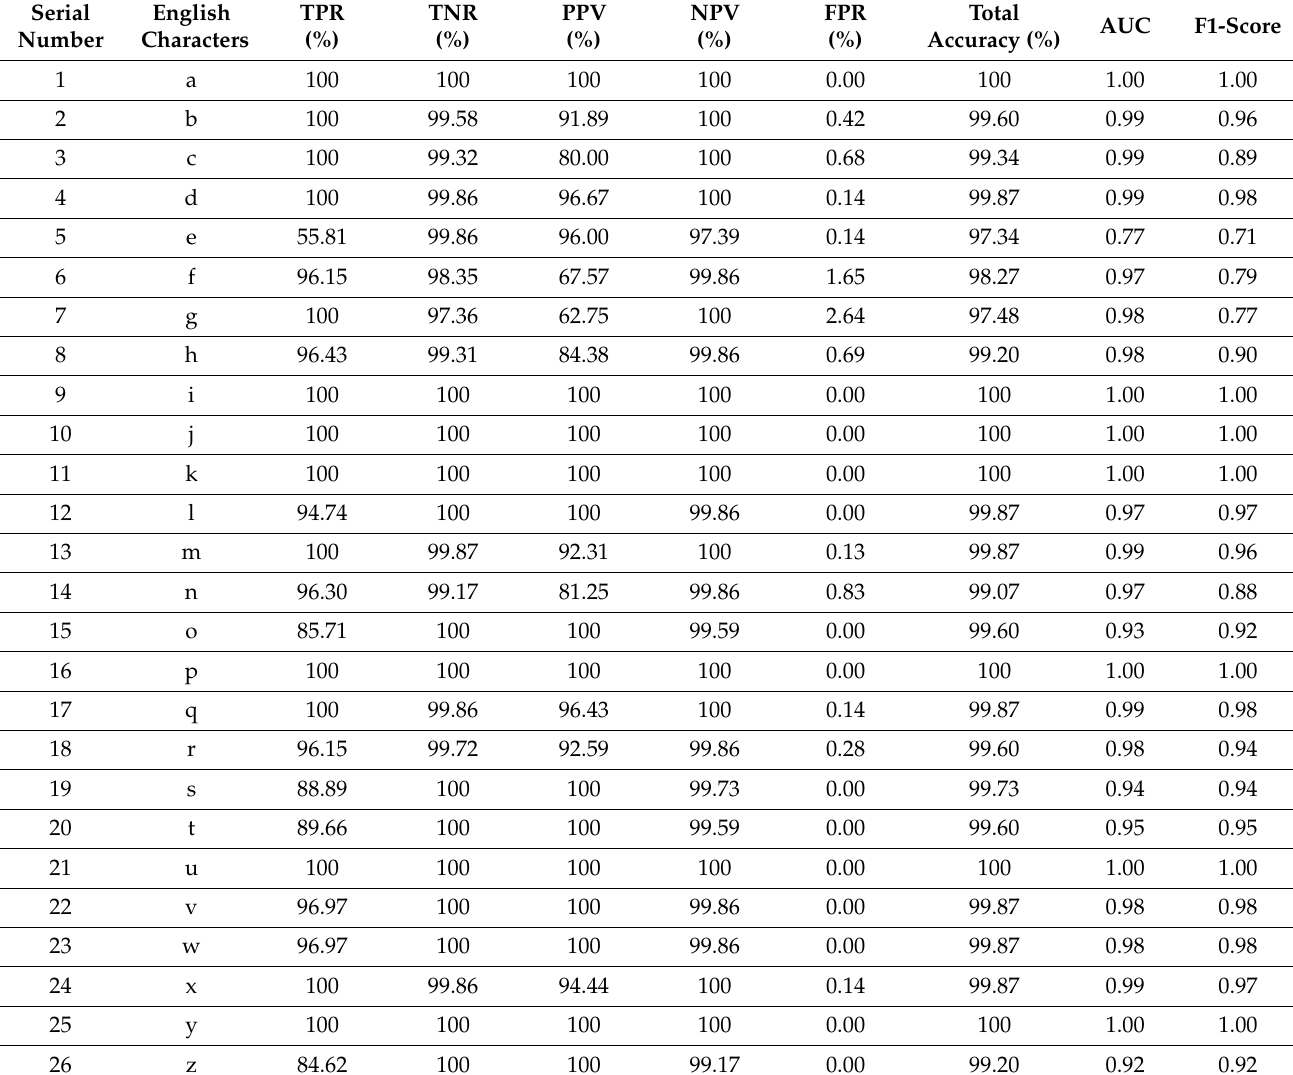
Table 3. Performance metrics showing the results obtained for the KNN